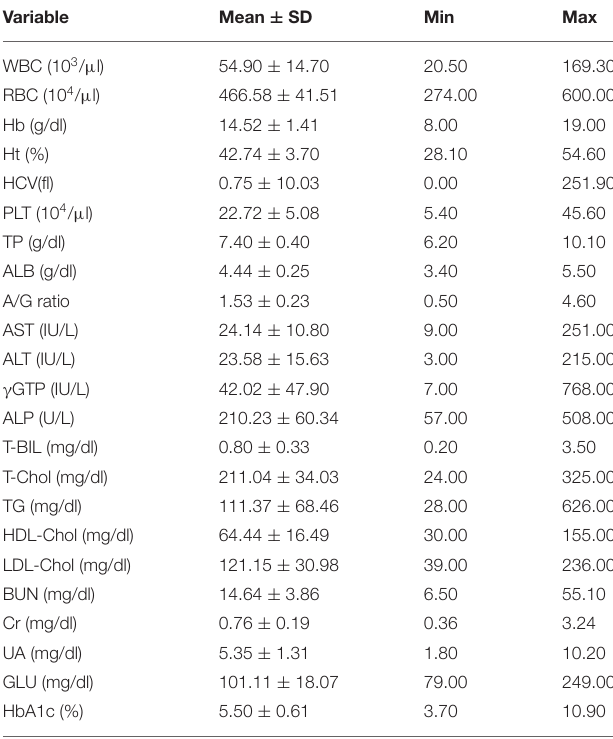
TABLE 1 | Blood test items for the estimation of GM-BHQ. Complete blood count